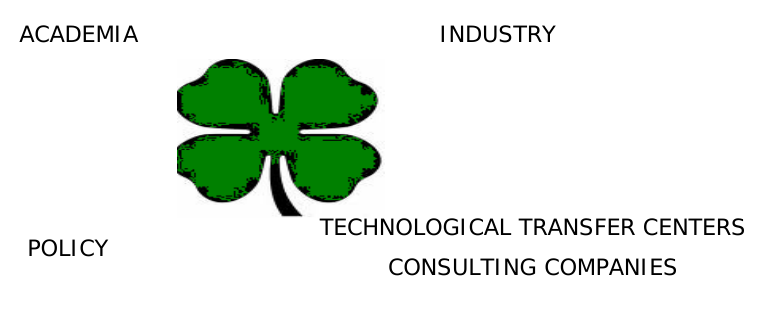
Figure 3. “Triple helix to product development”.